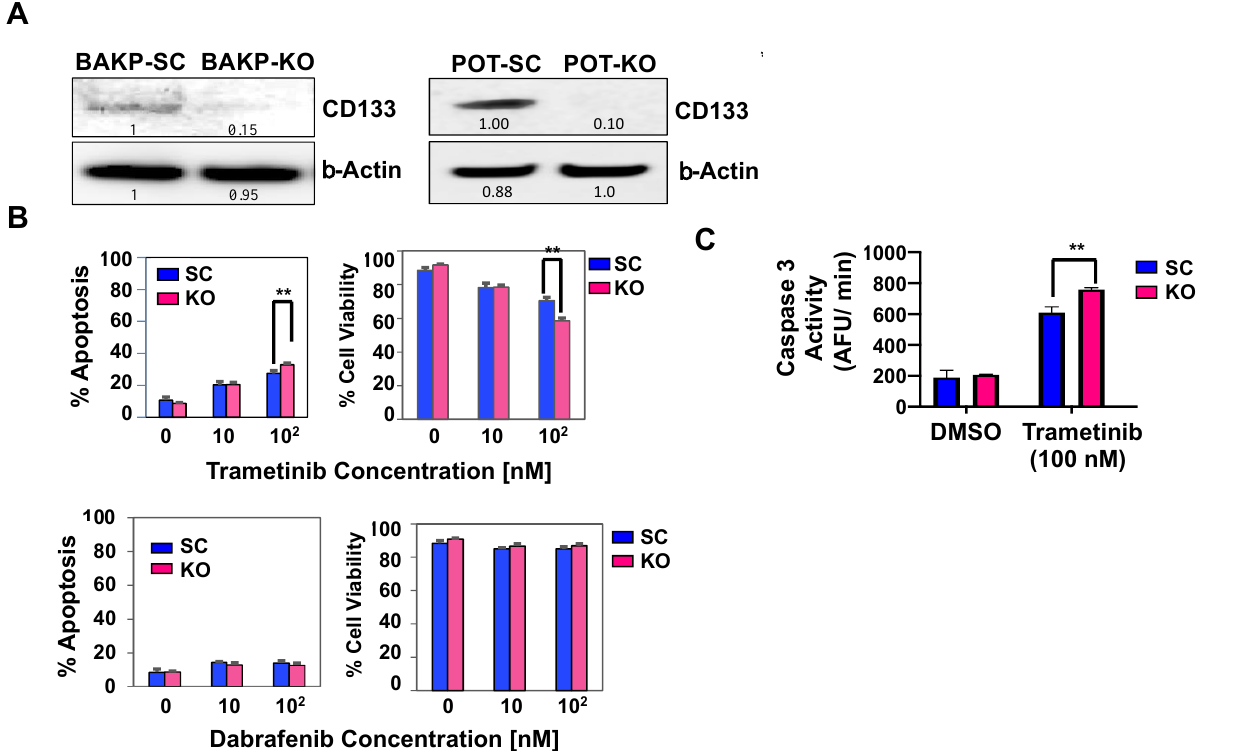
Figure 3. CRISPR-Cas9 knockout of CD133 expression in parental BAKP melanoma cells ( A ) increases caspase-3 mediated apoptosis ( B , C ) after exposure to trametinib. ( A ) Immunoblot analysis with anti-CD133 in BAKP-SC vs. BAKP-KO cells (left panel) and POT SC vs. POT-KO cells (right panel). ( B ) BAKP-SC and BAKP-KO cells were treated with indicated concentrations of trametinib (upper panels) or dabrafenib (lower panels) and subjected to Annexin FITC/PI apoptosis assays. Trametinib-treated CD133-depleted BAKP-KO cells display enhanced apoptosis relative to control BAKP-SC cells, an effect that was not seen with dabrafenib. ( C ) Fluorometric caspase-3 activity assays were performed 72 h after exposure of BAKP-SC and BAKP-KO cells to 100 nM trametinib. Results shown are the means ± SD of three biological replicates of a representative experiment; essentially the same results were obtained in three independent experiments. ** represents p < 0.01.